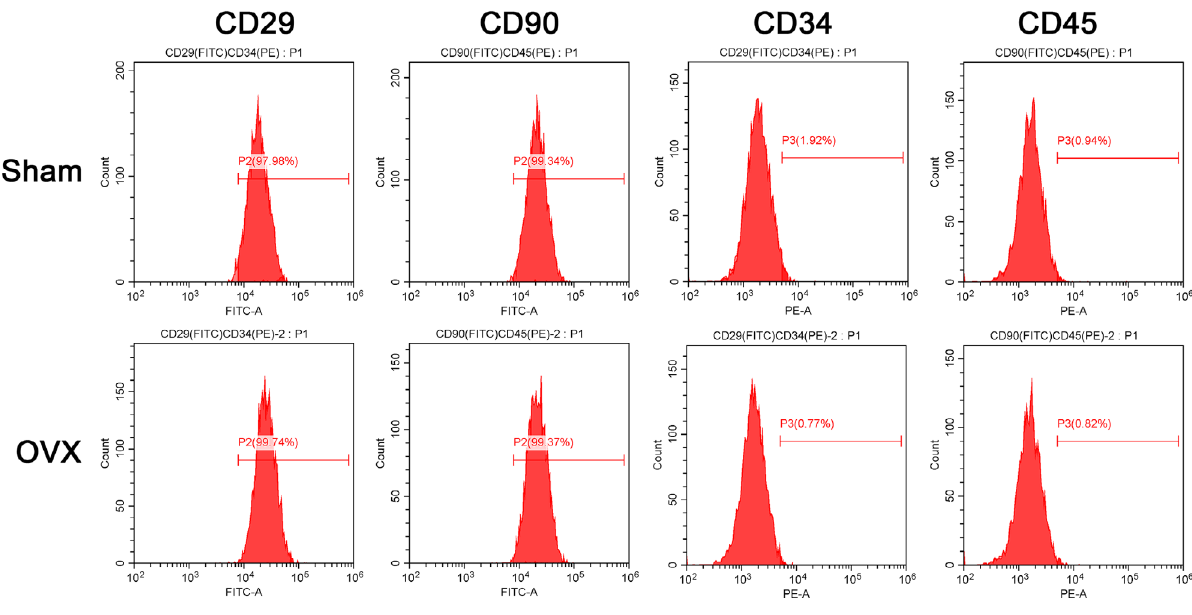
Figure 2 ‒ Identification of BMSCs by flow cytometry analysis. Representative images of flow cytometry analysis. Sham-BMSCs were positive for the surface antigens CD29 (97.98%) and CD90 (99.34%) and negative for CD34 (1.92%) and CD45 (0.94%). OVX-BMSCs were positive for the surface antigens CD29 (97.74%) and CD90 (99.37%) and negative for CD34 (0.77%) and CD45 (0.82%).